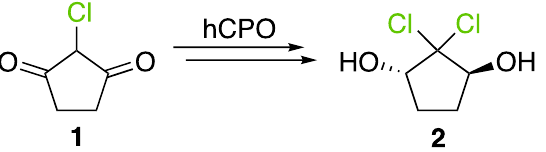
Figure 6. 2-chlorocyclopentane-1,3-dione ( 1 ) chlorination to form caldariomycin ( 2 ) inspired by [84].